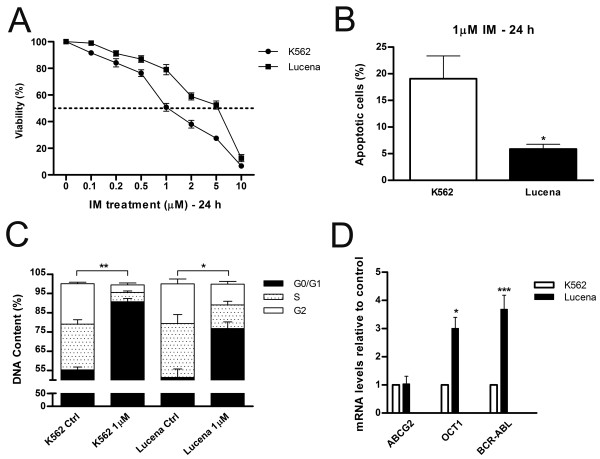
Panel of Lucena cross-resistance to IM treatment. (A) K562 and Lucena cell lines were treated with a range of IM doses for 24 h. Cell viability was measured by trypan blue exclusion assay. Apoptotic cells (B) and cell cycle (C) were measured by flow cytometry after 1 μM of IM treatment in both cell lines. (D) ABCG2, OCT1 and BCR-ABL mRNA expression levels in K562 and Lucena cell lines were quantified by RT-qPCR. Expression values were normalized to β-actin expression. Values represent the means of three independent determinations ± s.d. (*p < 0.05; **p < 0.01; ***p < 0.001)